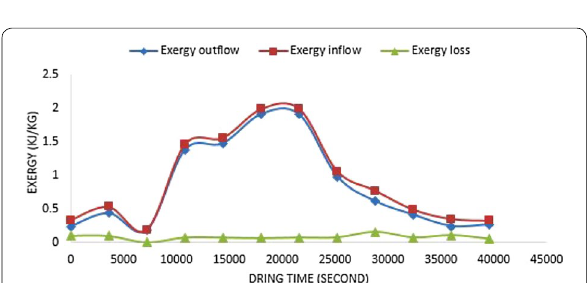
Fig. 7 Exergy as a function drying time (1st day) potato